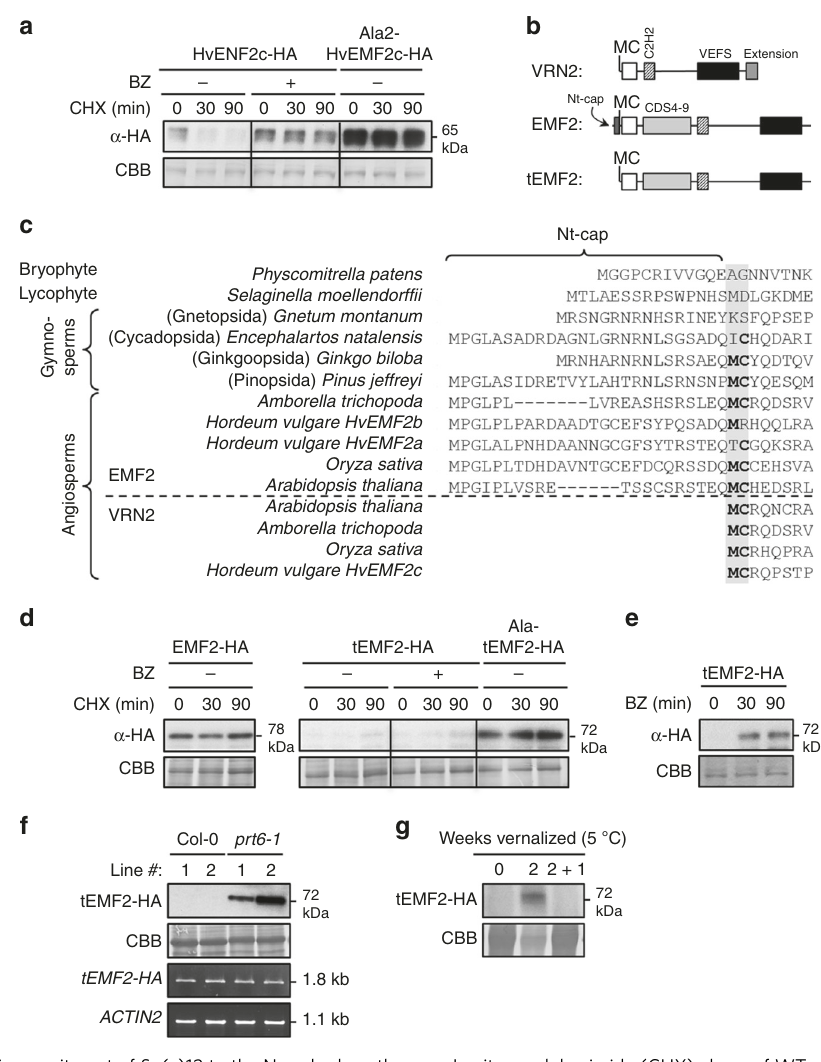
Fig. 5 Angiosperm-speci fi c recruitment of Su(z)12 to the N-end rule pathway. a In vitro cycloheximide (CHX) chase of WT and mutant (Ala2) variants of the barley VRN2-like protein HvEMF2c (±bortezomib; BZ). b Schematic showing the structure and key domains of Arabidopsis VRN2, EMF2 and truncated tEMF2. c Sequence alignment of the Nt of EMF2 and VRN2 proteins from land plants (above and below dashed line, respectively), showing the position of the MC dipeptide. For sequences see Supplementary Data 4. d In vitro CHX chase of full-length Arabidopsis EMF2-HA (initiating MP-), and WT or mutant (Ala2) tEMF2-HA, ±BZ. e In vitro accumulation over time of tEMF2-HA expressed in rabbit reticulocyte when co-incubated with BZ, but without CHX. f In vivo steady state protein and RNA levels of truncated WT tEMF2-HA in Col-0 vs prt6 -1. Two independent transformants are shown. g Protein levels of tEMF2-HA in Col-0 during a vernalization timecourse. Source data are provided as a Source Data fi Methods Plant growth and materials . A. thaliana (Arabidopsis) seedlings were obtained from the Arabidopsis Stock Centre (NASC), except for: VRN2-FLAG 15 (from Dr. Chris Helliwell, CSIRO, Australia), and pFLC::FLC-GUS (C24 ecotype, containing 6kb FLC-GUS construct 31 , from Dr. Candice Sheldon, CSIRO, Australia). The 35S::HRE2-HA and 35S::RAP2.3-HA transgenic lines, as well as prt6-1 , ate1-2 ate2- 1 and prt6-1 erfVII sextuple mutants were described previously 19,21,27,28 . Molecular characterisation of vrn2-5 (SALK_201153) is described in Supplementary Figure 5. Mutant combinations were generated by crossing, and con fi rmed by PCR geno- typing and RT-PCR (primers in Supplementary Table 1). Seeds were surfaced sterilized in 20% Parazone, plated on half-strength Murashige and Skoog (MS) medium (1% agar, pH 5.7, grown vertically), and strati fi ed at 4°C for a minimum of 2 days, before being transferred to long day (LD; 16 h L:8h D) condition under white fl uorescent light (90 – 100 μ molm − 2 s − 1 ) at 22 °C, and transferred to soil after 2 weeks if necessary. Plant phenotypic analyses . For the waterlogging assays, 12days old seedlings were transferred to soil and grown under neutral days (ND; 12 h L:12h D). Two replica trays were set up with genotypes distributed quasi-randomly. After 12 further days of growth in soil, one tray was subjected to waterlogging for 21 days (water level maintained at the soil surface), whilst the other (control) was watered as normal